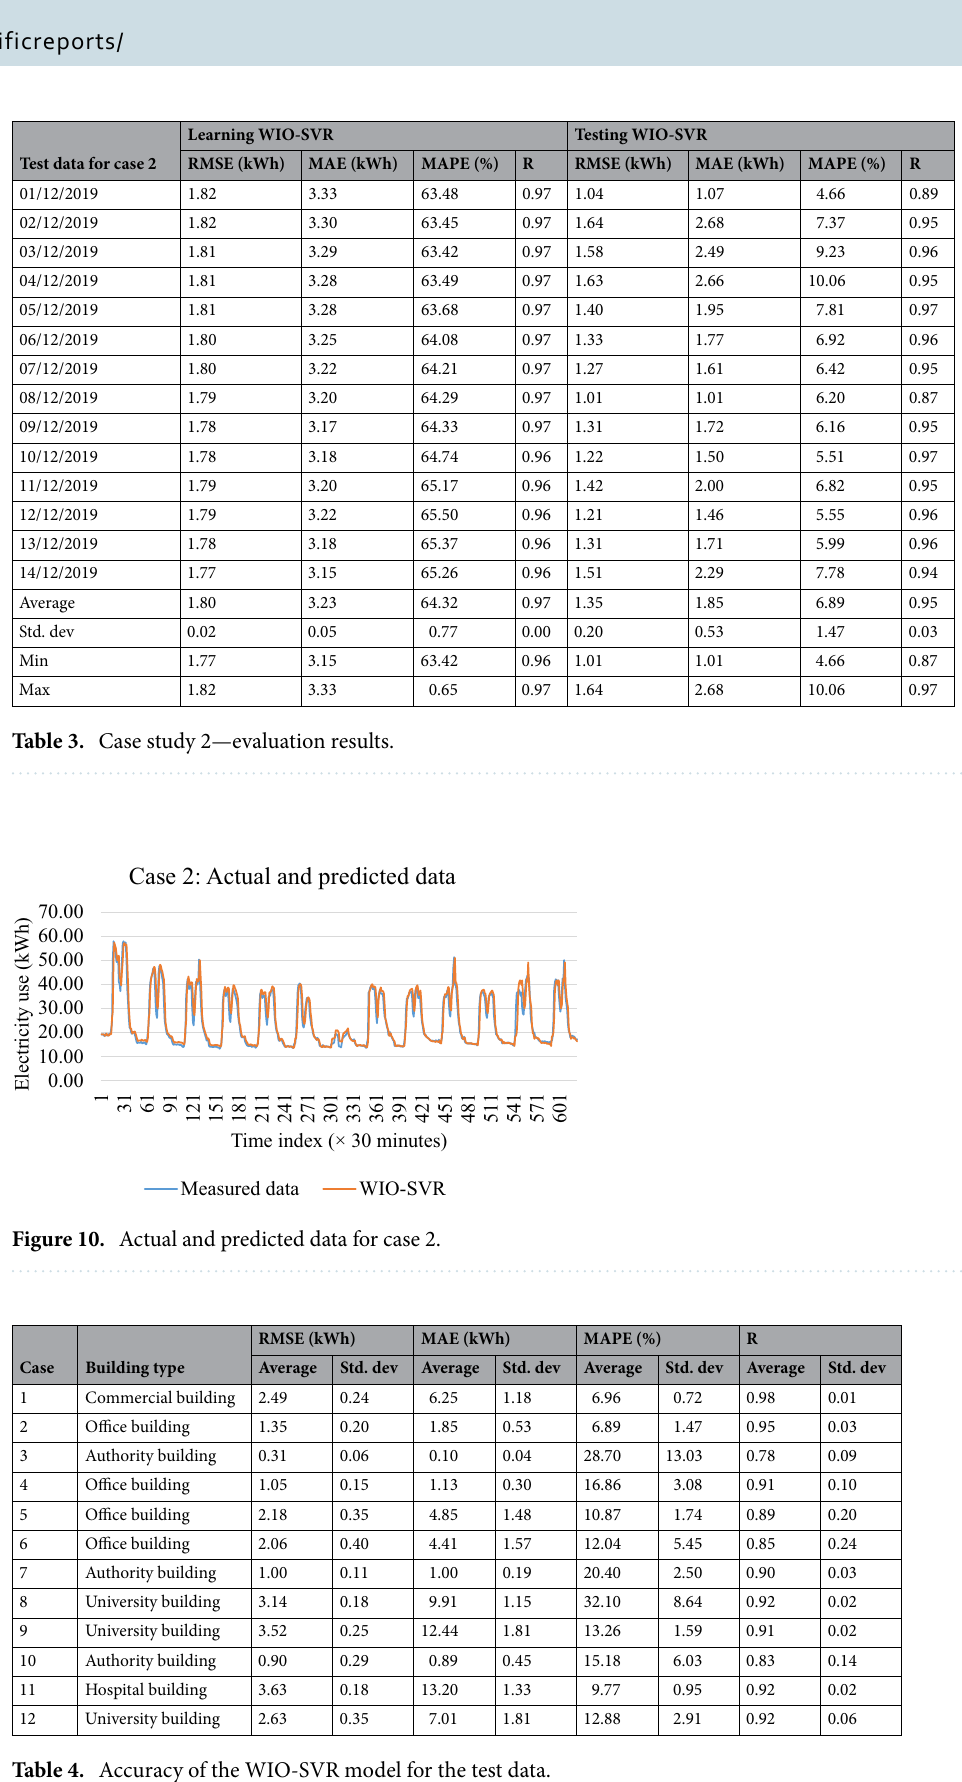
Table 4. Accuracy of the WIO-SVR model for the test